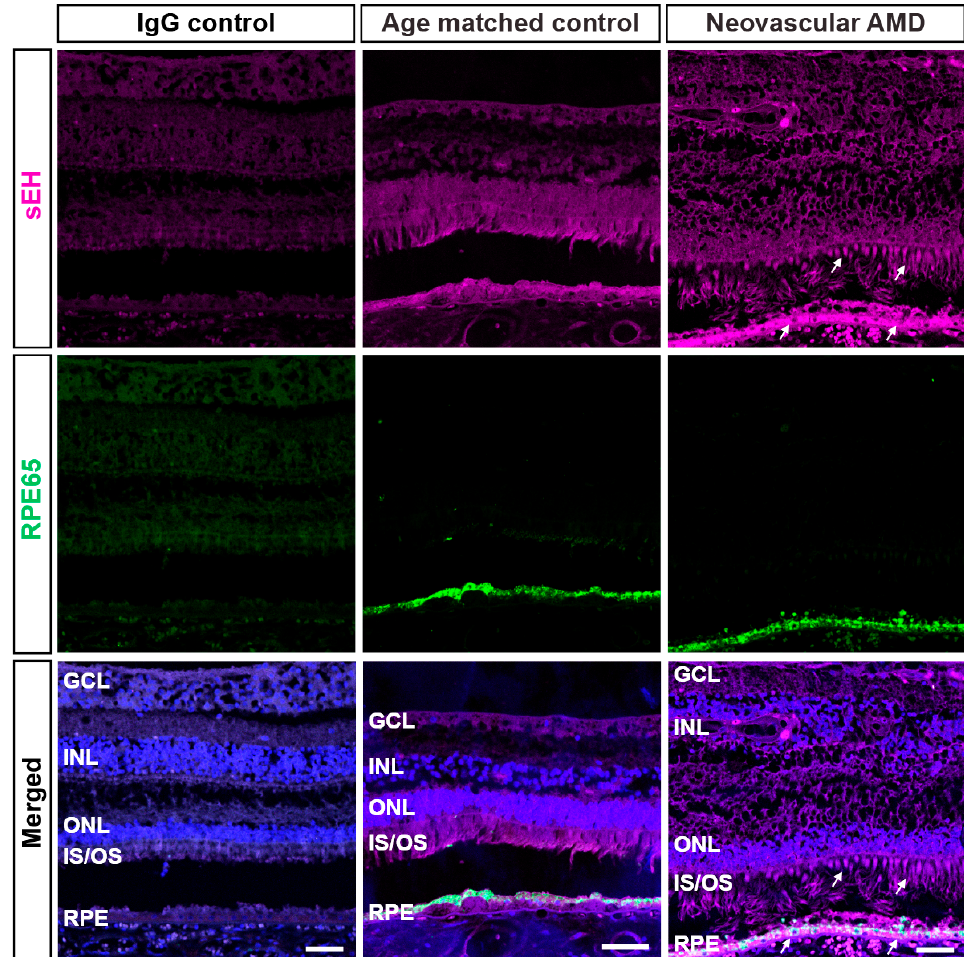
Figure 2. Colocalization of sEH with RPE in human retinas from neovascular AMD subjects. Repre- sentative images of central retinal sections from neovascular AMD (81 y.o., male) and age-matched control eyes (82 y.o., male) stained with DAPI (blue) , sEH (magenta), or RPE65 (green). IgG control is from a normal control eye (34 y.o., male) with preimmune serum instead of primary antibody. Immunohistochemistry using antibodies against sEH and RPE65 shows positive staining of sEH in RPE cells with more intense expression in neovascular AMD retinal tissue (indicated by arrows). Scale bars: 50 μ m. Representative images from n = 2 control and n = 3 nAMD subjects; see also Figure S1.